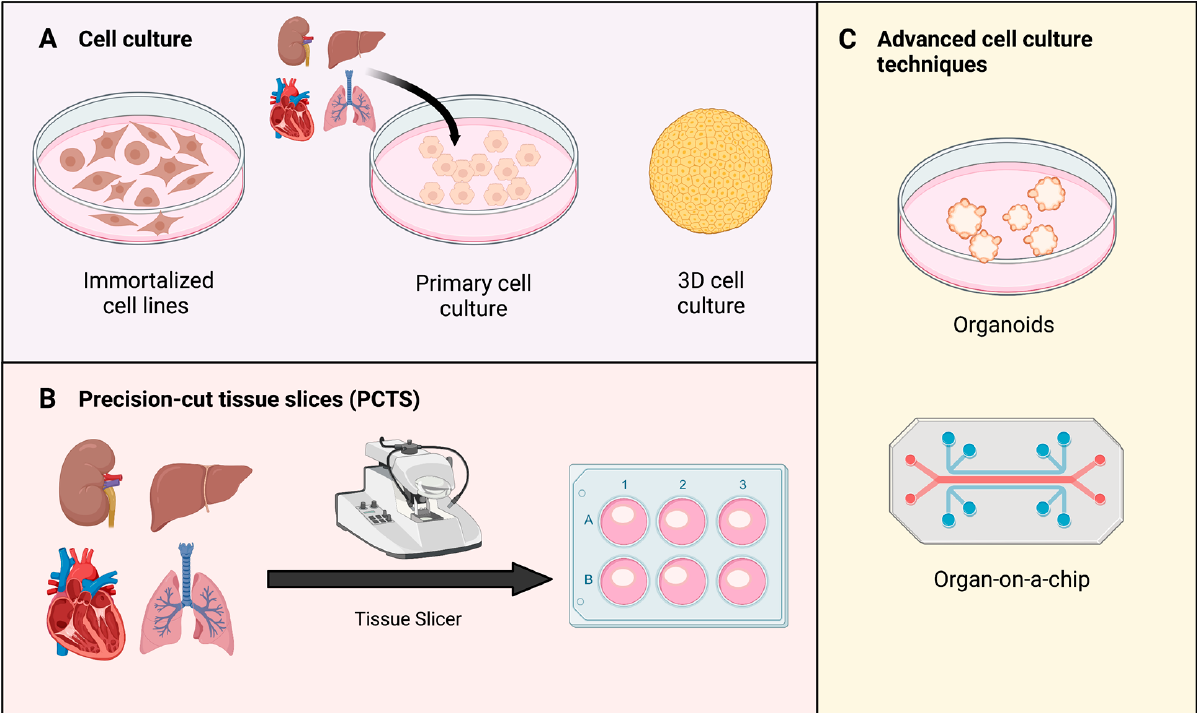
Figure 3. Types of in vitro models to study oxidative stress. ( A ) Cell culture can be sourced from immortalized and primary cell lines. In complex models, 3D cell cultures are prioritized over 2D monolayer culture [108]. ( B ) Precision-cut tissue slices (PCTS) are obtained from tissue of interest using a specific tissue slicer. Produced slices can be transferred and assessed in regular cell culture environment thereafter [109]. ( C ) Examples of advanced cell culture techniques: organoids and organs-on-a-chip. Organoids are 3D tissue structures grown from stem cells [110]. Organ-on-a-chip represent a new model to study impact of temperature, shear-stress, and oxygenation [111].